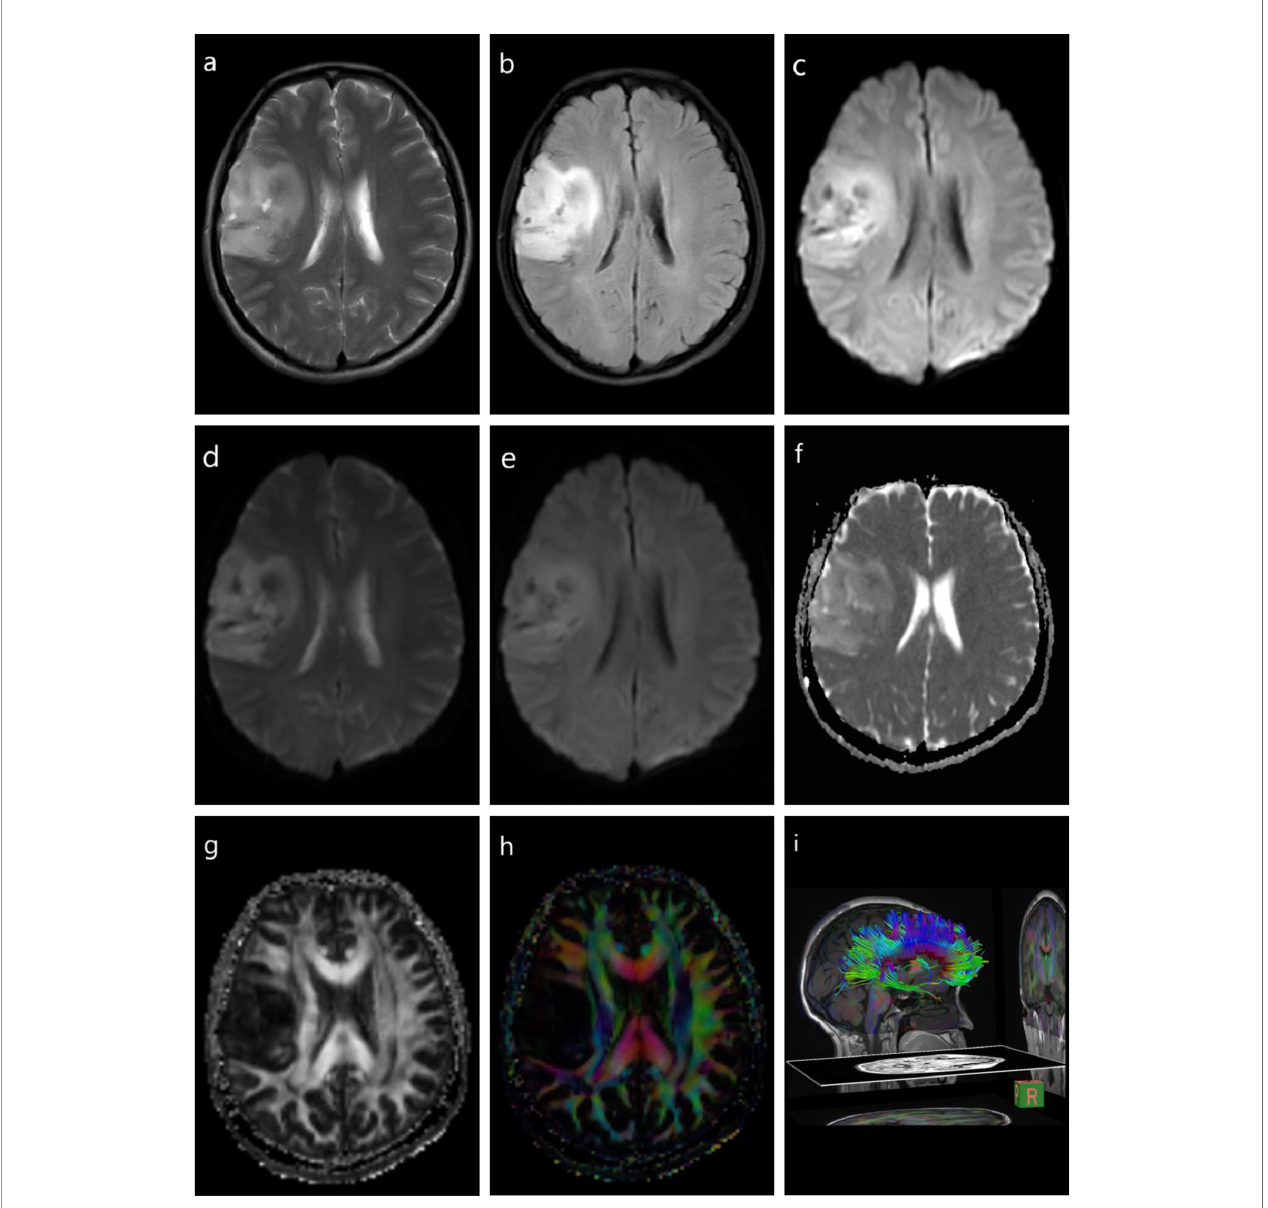
FIGURE 1 | Diffusion-weighted imaging (DWI) and diffusion tensor imaging (DTI) of a glioma. T1-weighted imaging (T1WI) (A) , fl uid-attenuated inversion recovery (FLAIR) (B) , DWI (C) , DWI with b = 0 s/mm 2 (D) , DWI with b = 1,000 s/mm 2 (E) , DTI apparent diffusion coef fi cient (ADC) mapping (F) , DTI fractional anisotropy (FA) mapping (G) , DTI directional encoded color FA mapping (H) , diffusion tensor tractography (DTT) (I)